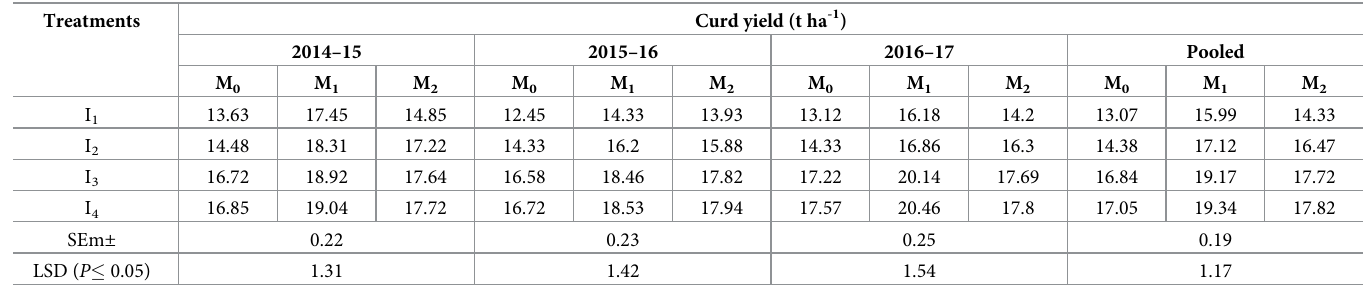
Table 3. Interaction effects of different methods and levels of irrigation and mulches on broccoli curd yield.